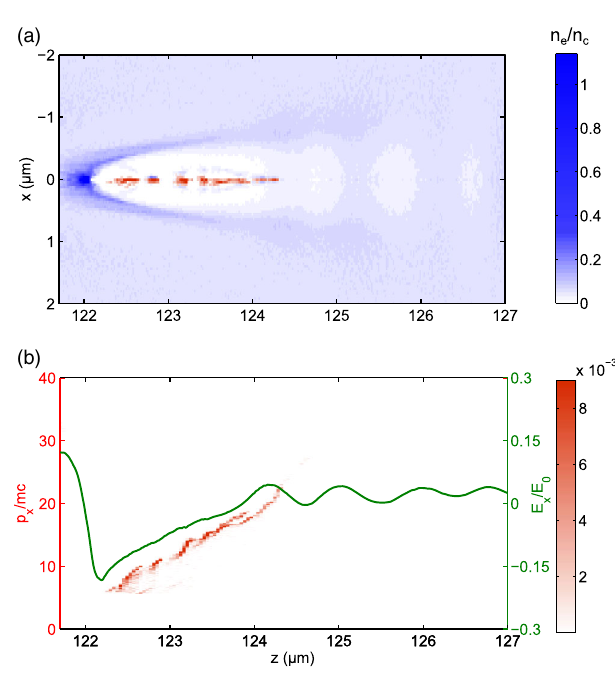
FIG. 1. Results of PIC simulations. (a) Map of the electron density in the plasma ( n e =n c blue color bar): the 5-fs laser pulse drives a plasma cavity, in which high-energy electrons are accelerated (red color bar). (b) Longitudinal phase space density map showing an accelerated electron bunch with energy in the 5 – 10 MeV range. The green curve is the wakefield longitudinal electric field originating from the plasma